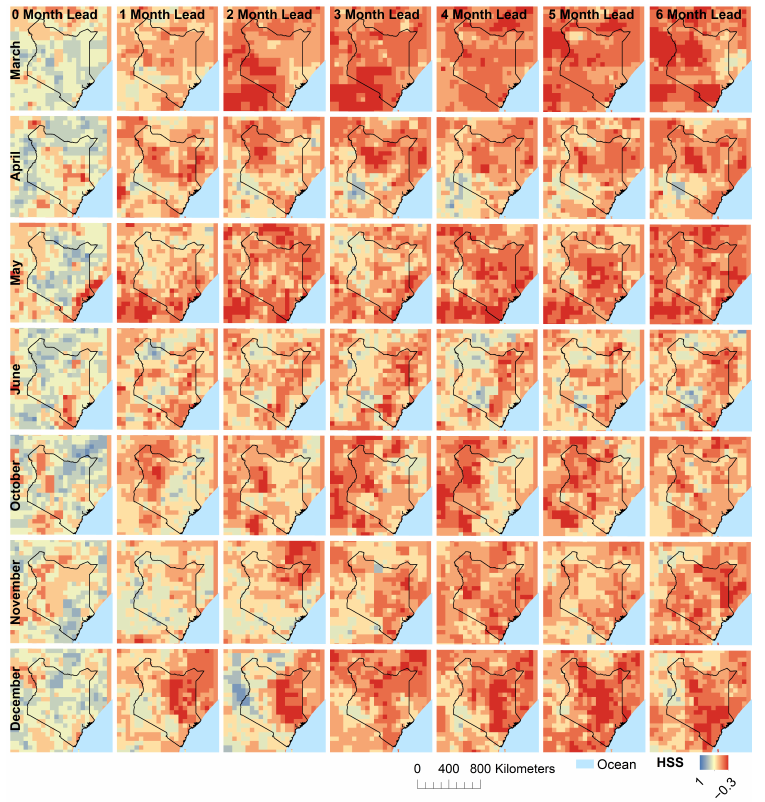
Figure 10. This image shows the Heidke skill score over individual months for wet anomaly